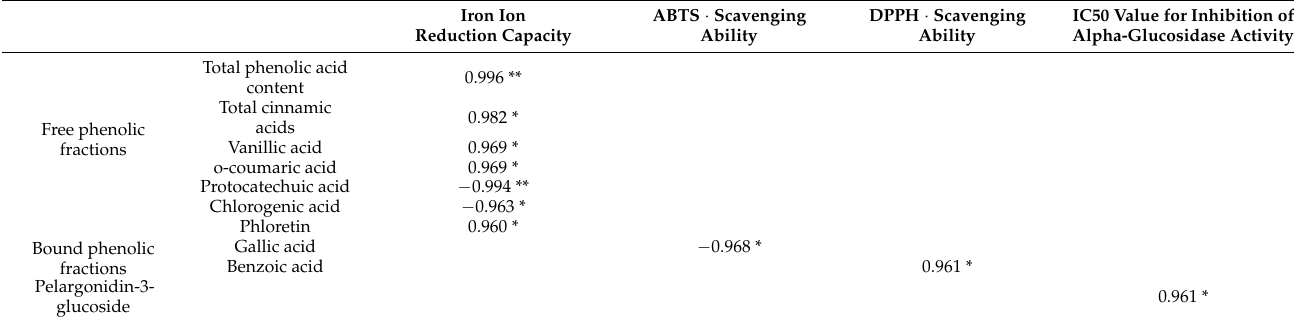
Table 4. The table of correlation